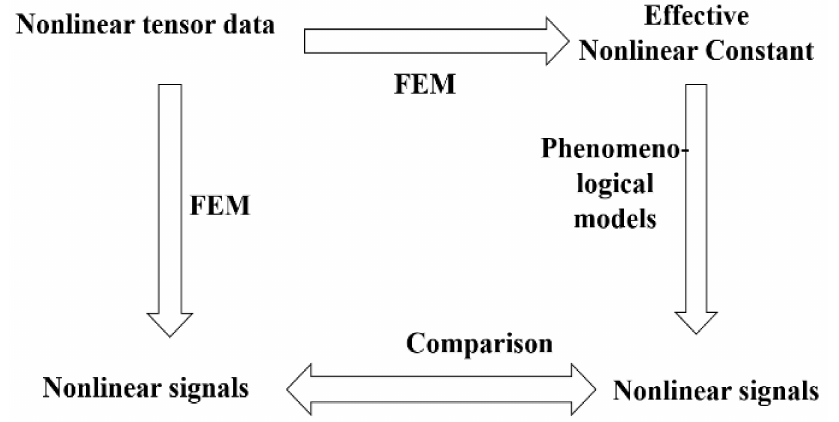
Figure 5. The relation between the FEM model and phenomenological